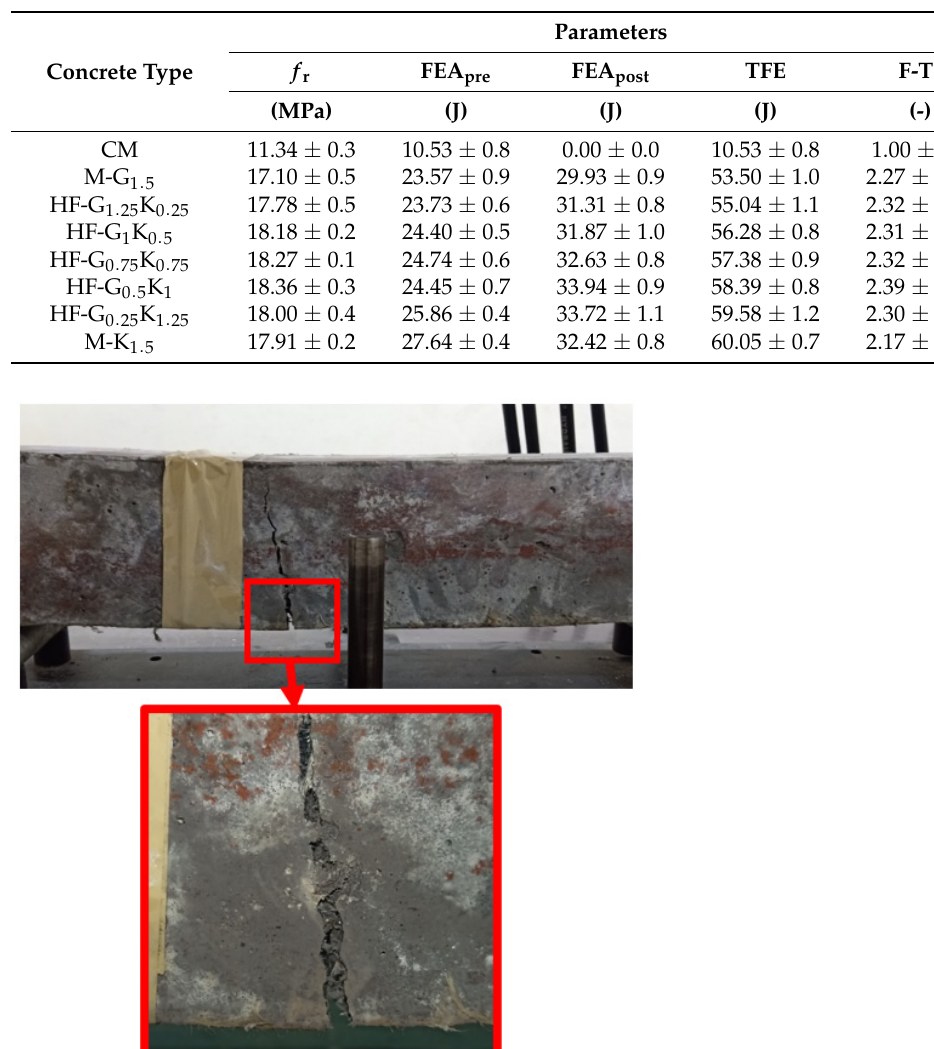
Figure 6. Percentage comparison of concrete properties during compression. Table 9. Properties of concrete specimens under flexural loading.